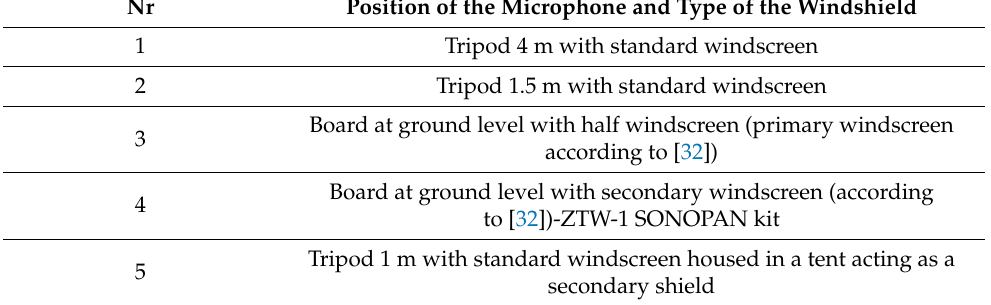
Table 3. Measuring methods for sound pressure.